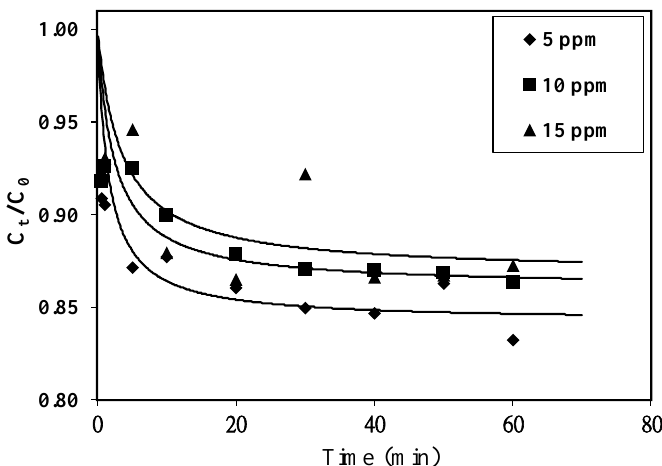
Figure 7. Plots of dimensionless concentration (C t /C 0 ) vs. adsorption time at different initial MB concentrations (C o ). Full lines: calculated from Equation (5) and Table 3. Table 3. Adsorption kinetic parameters for the adsorption of methylene blue (MB) onto the optimal biochar (CPH-BC-800-AW). a.